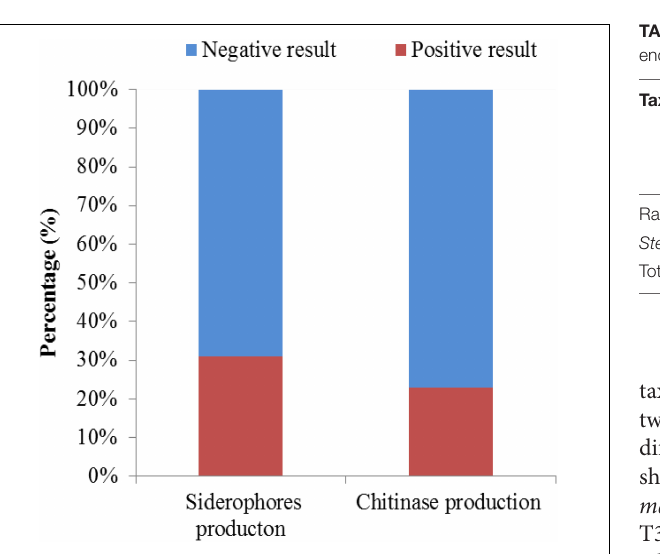
FIGURE 8 | The chitinase- and siderophore-producing activities of